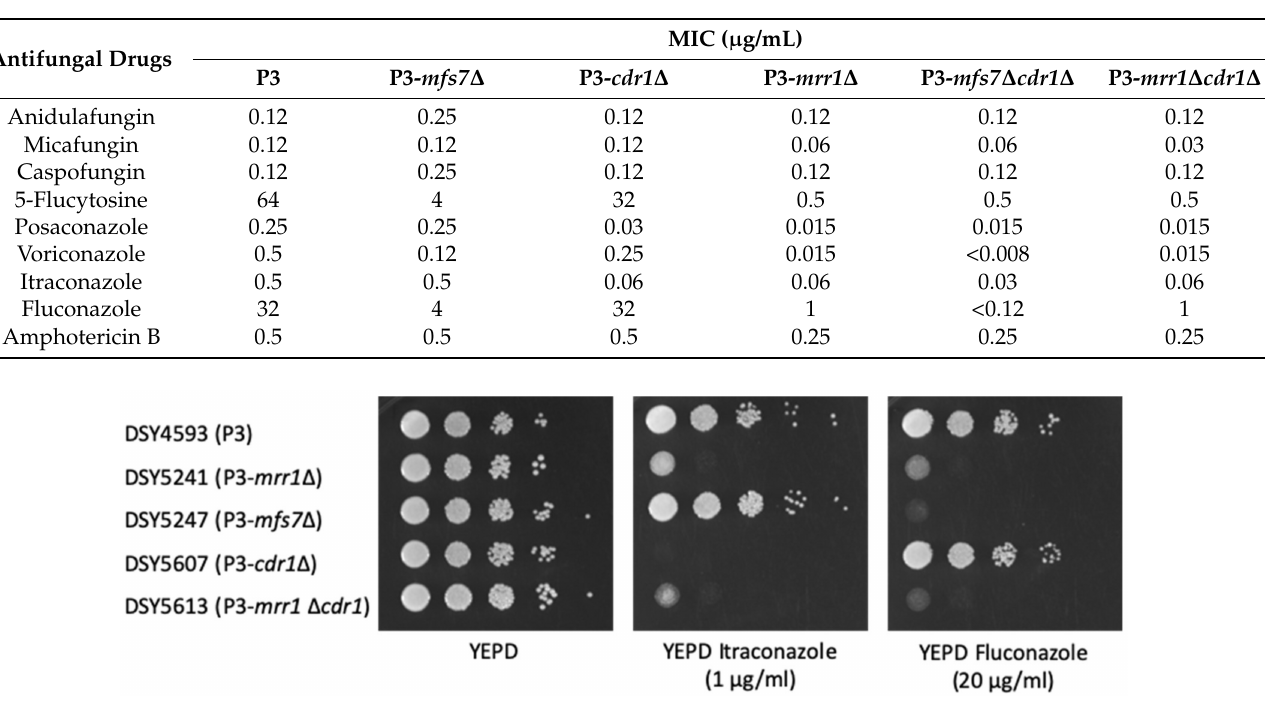
Figure 3. Pairwise comparisons of MICs between isolate P3 and derived mutants. Fold-changes are given in log2 scale. Comparisons were made always starting from top row. Values > 0 indicate MIC decreases, while values <0 indicate MIC increases. Greyed colored boxes indicate comparisons between same isolates (Value = 0). Table 2. Antifungal MICs of C. lusitaniae P3 and mutant derivatives.